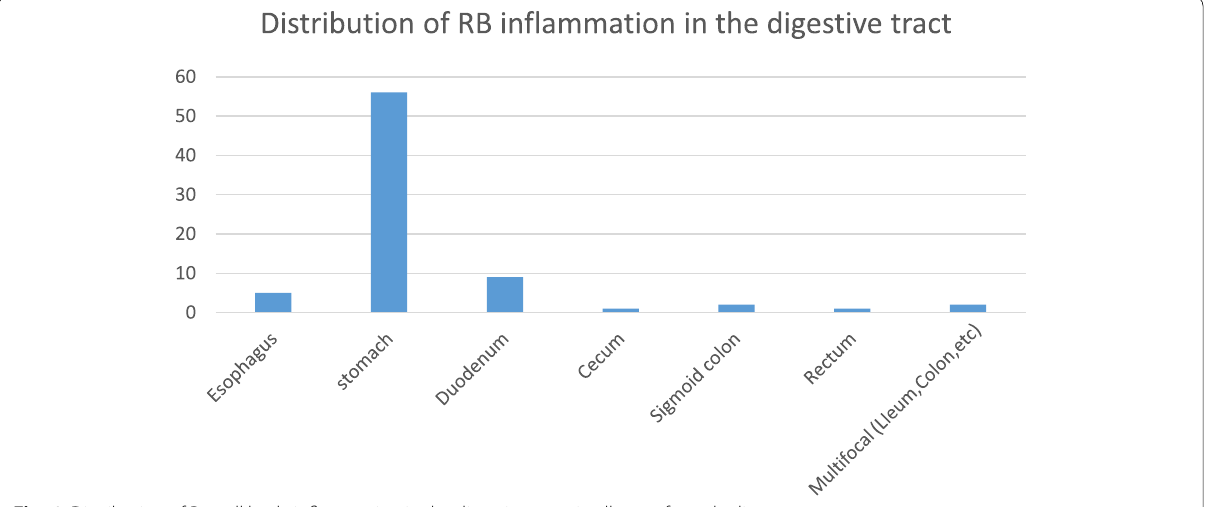
Fig. 6 Distribution of Russell body inflammation in the digestive tract: in all cases from the